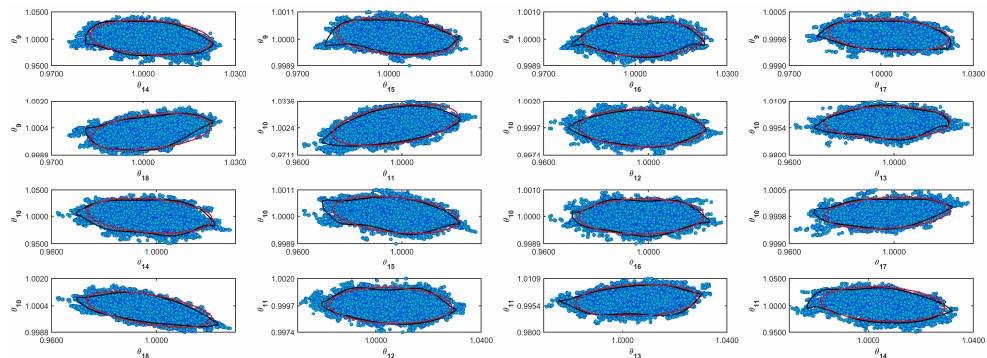
Figure A8. Coverage regions of parameters 08: (—) Gaussian region; (—) Possolo [33] region.